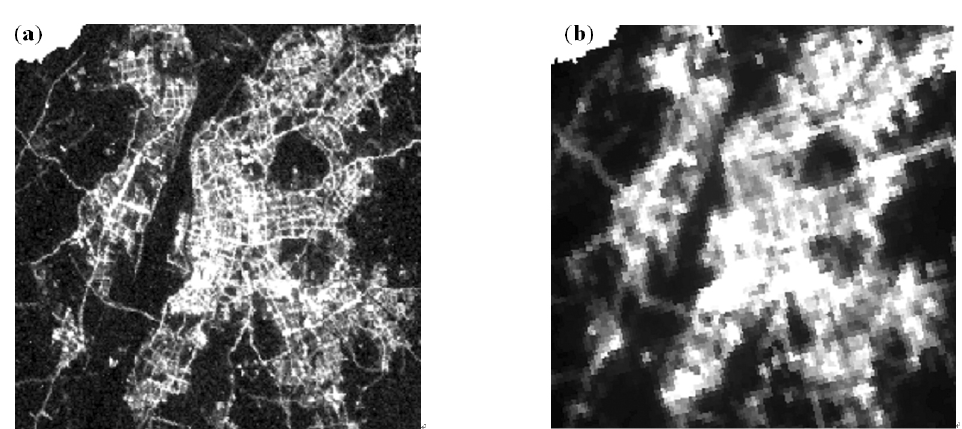
Figure A1. Comparison of the spatial resolutions of nighttime light (NTL) remote sensing data sources in the study area. ( a ) Luojia 1-01 image acquired on 23 November 2018. ( b ) VIIRS monthly synthetic product for December 2018.